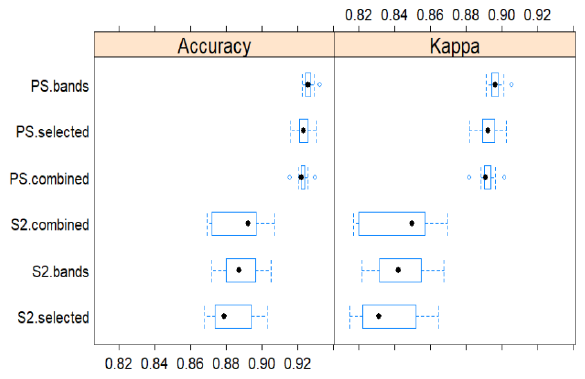
Figure 3: Model prediction performances using Accuracy and Kappa for bands only variables (*.bands), combined indices and bands(*.combined) and Guided Regularized Random Forest (GRRF) selected variables (*.selected) using PlanetScope (PS) and Sentinel-2 (S2)